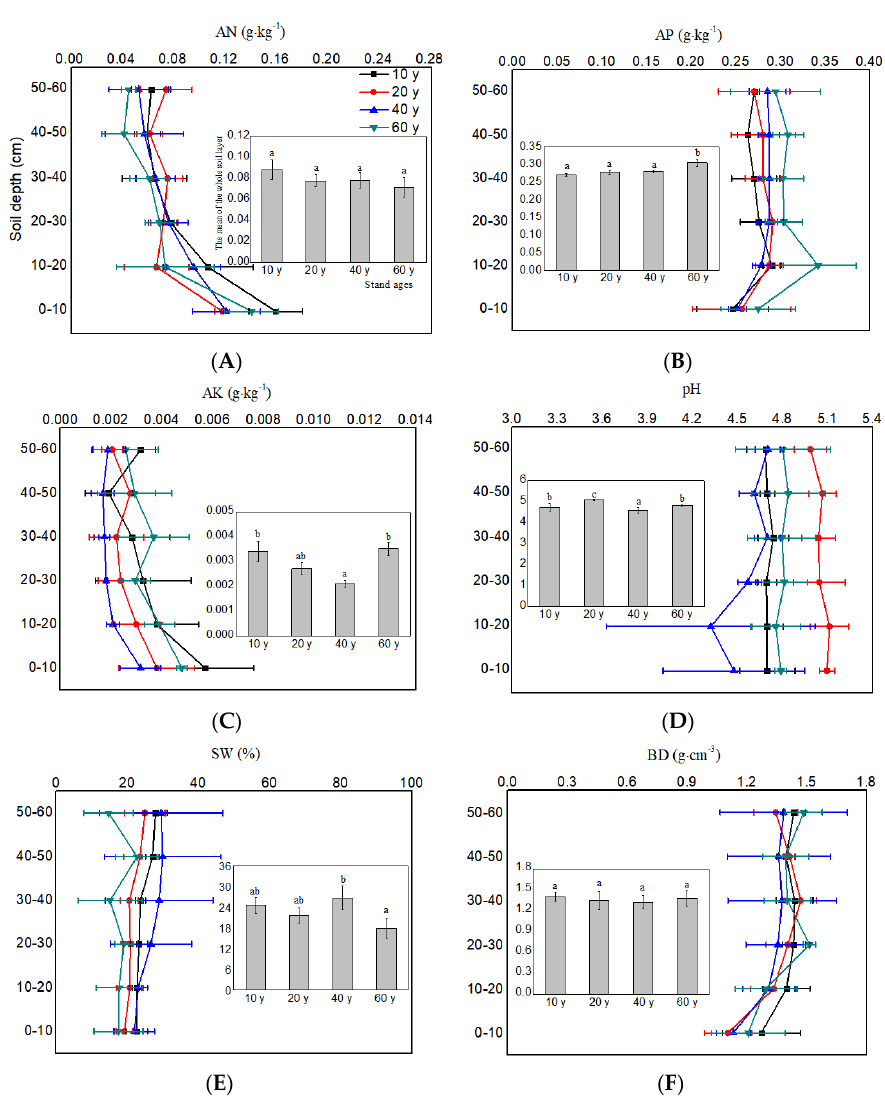
Figure 2. Physical and chemical properties of soil in Masson pine plantations of different ages. Different small letters indicate significant differences ( p < 0.05). The histogram displays the average value from 0 to 60 cm and the curve shows the measured value from 0 to 60 cm. AN, AP, AK, SW, and BD represent soil available nitrogen, available phosphorus, available potassium, water content, and bulk density, respectively. ( A – F ) represents soil available nitrogen, available phosphorus, available potassium, pH, water content and bulk density, respectively.